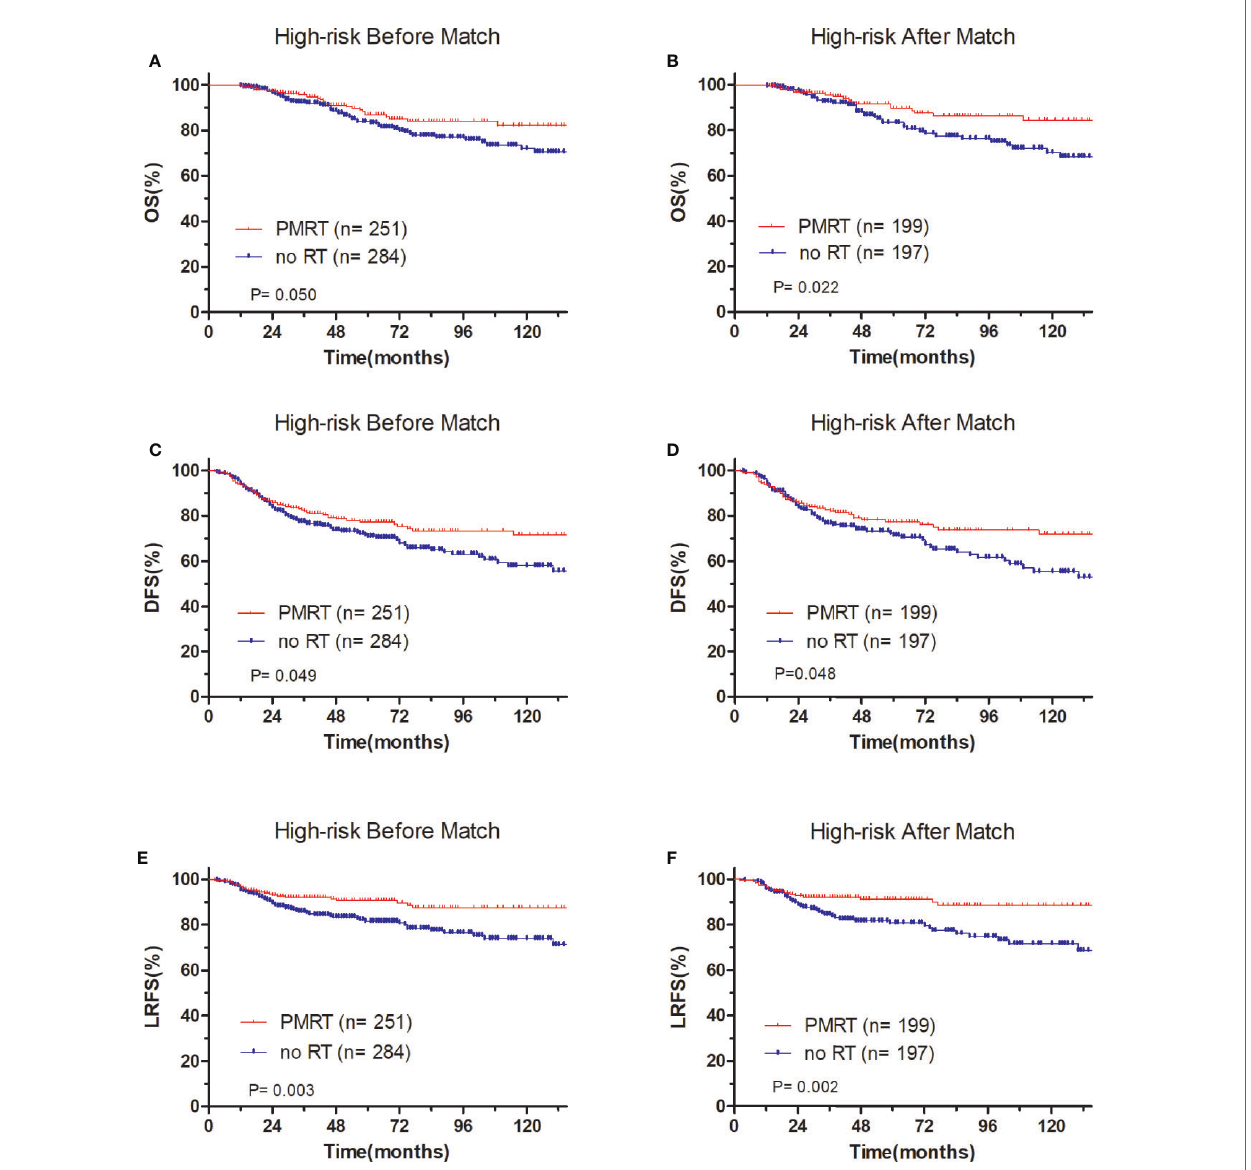
FIGURE 6 | Comparison of OS and DFS and LRFS between with PMRT and without PMRT for high-risk pT1-2N1M0 patients. For patients with PMRT or without PMRT, OS before (A) and after (B) match strati fi cation; DFS before (C) and after (D) match strati fi cation; LRFS before (E) and after (F) match strati fi